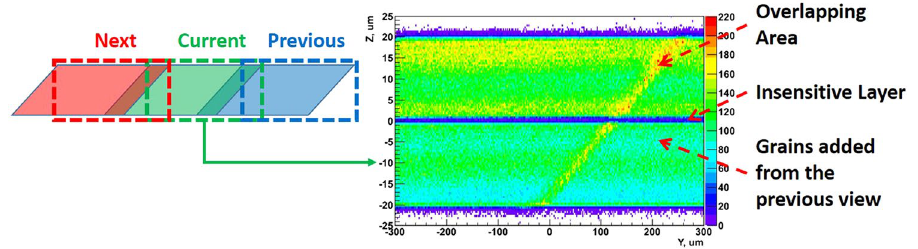
Figure 6. Illustration of the view reshaping procedure.